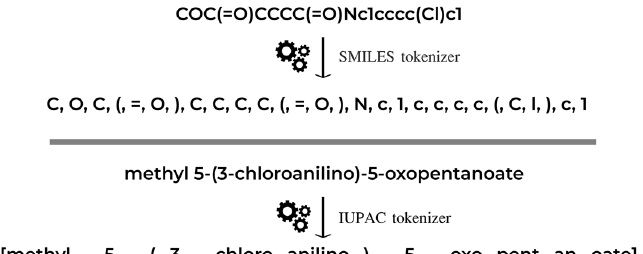
Figure 1. Demonstration of SMILES tokenization (top) and IUPAC names tokenization